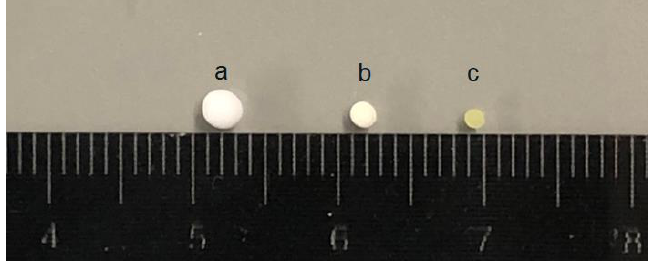
Figure 2. From left to right: ( a ) Freeze-dried oxidized cellulose beads (OCBs)-4 without drug loading. ( b ) OCBs-4 loaded with IND in DCM. ( c ) OCBs-4 loaded with IND in acetone.